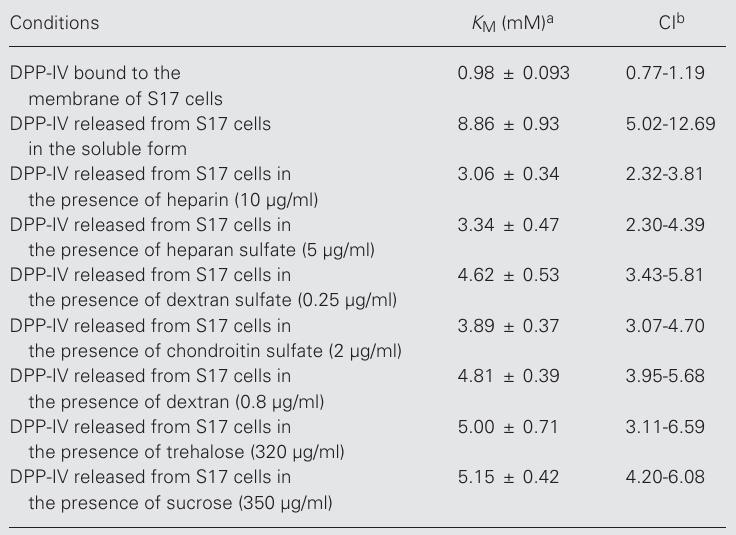
Table 2. Effect of glycosaminoglycans and sugars on the K M of dipeptidyl peptidase IV (DPP-IV) in S17 cells. Conditions